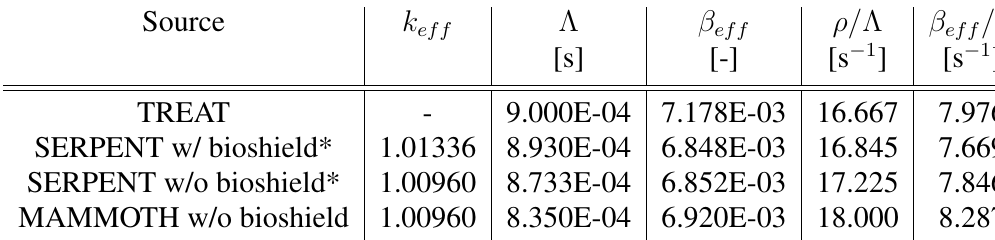
Table 2: Kinetic parameters for the 1.5% Δ k/k transient based on a half-slotted TREAT configuration